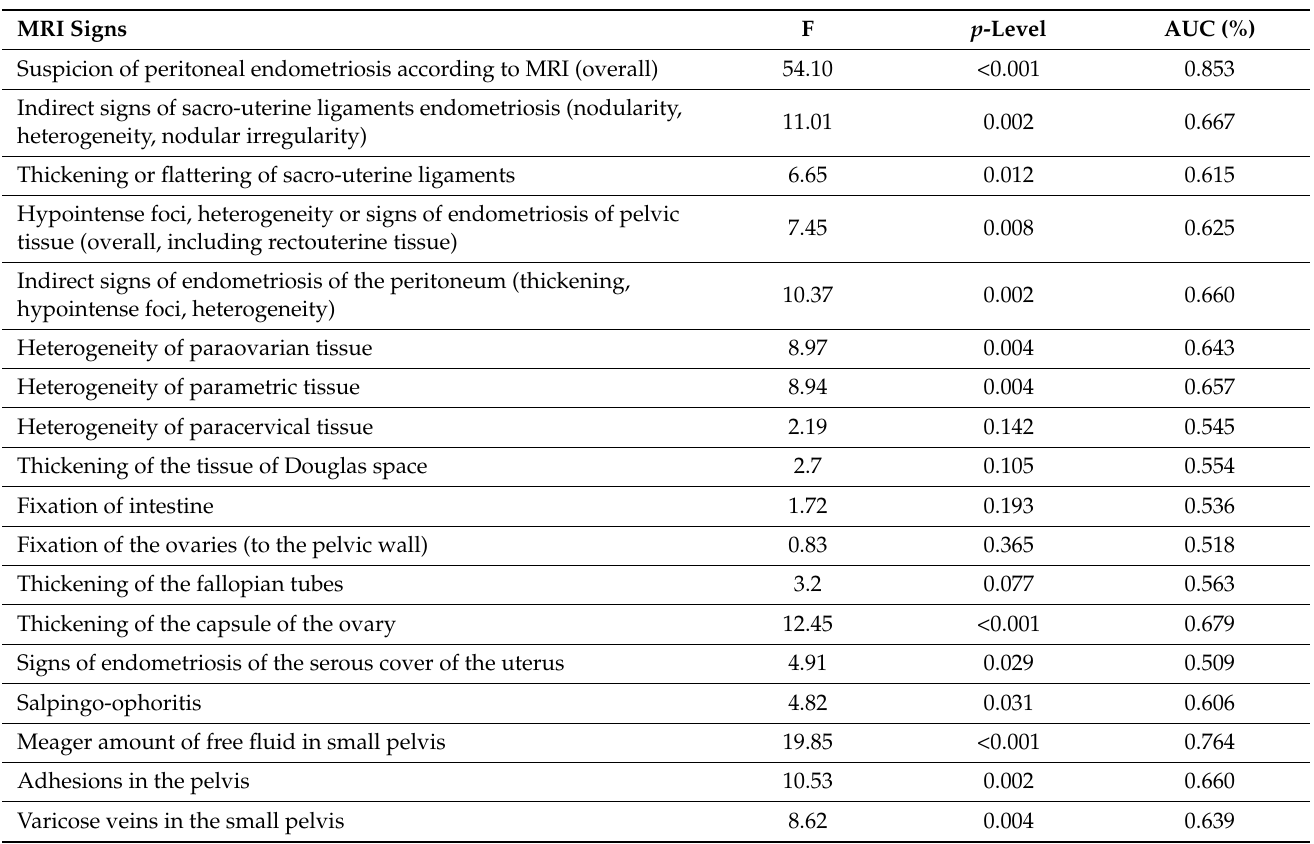
Figure 3. Localization of endometriotic foci according to MRI in adolescents. Table 3. Significance of the MRI signs in the prediction of laparoscopic conformation of peritoneal endometriosis in